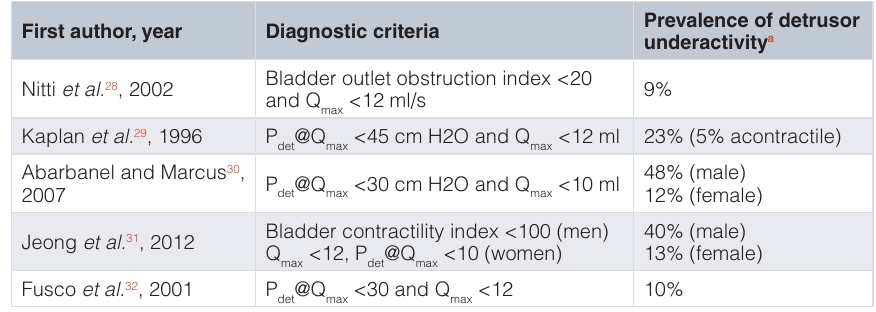
Table 1. Diagnostic urodynamic criteria used to define detrusor